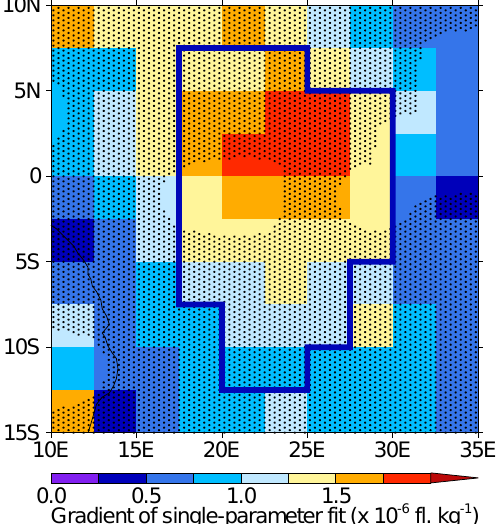
Figure 4. The gradients from single-parameter fitting of individual grid cells in Central Africa. The stippling shows grid cells with correlations significant at the 95% level. Grid cell fits are made using the 12 monthly points for the cell in the year 2002. The solid blue line outlines the model under-estimated cells from the blue region in Fig. 4.